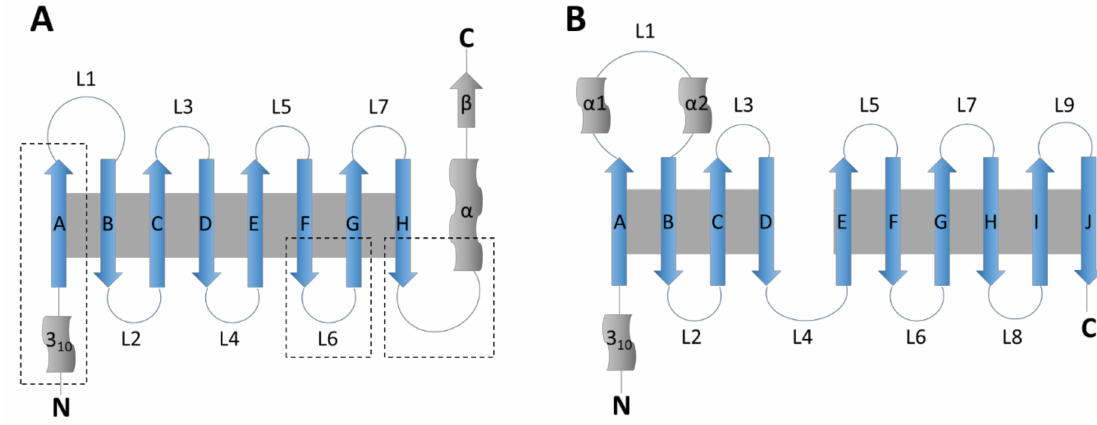
Figure 1. Schematic structures of the lipocalin and fatty acid binding protein family (adapted from [4]). ( A ) Lipocalin structure. The β -strands forming the β -barrel are represented as arrows labeled A–H and the loops as circular lines labeled L1–L7. The short N-terminus 3 10 -helix and the C-terminus α -helix and short β -strand are also represented. Grey background represents hydrogen bonds between strands. Dotted squares surround the three structurally conserved regions of kernel lipocalins. ( B ) Fatty acid binding protein structure. The β -strands are represented as arrows labeled A–J and the loops as circular lines labeled L1–L9. Two conserved α -helixes in loop L1 are shown as α 1 and α 2. The N-terminus 3 10 -helix and the C-terminus are also represented. Grey background represents hydrogen bonds between